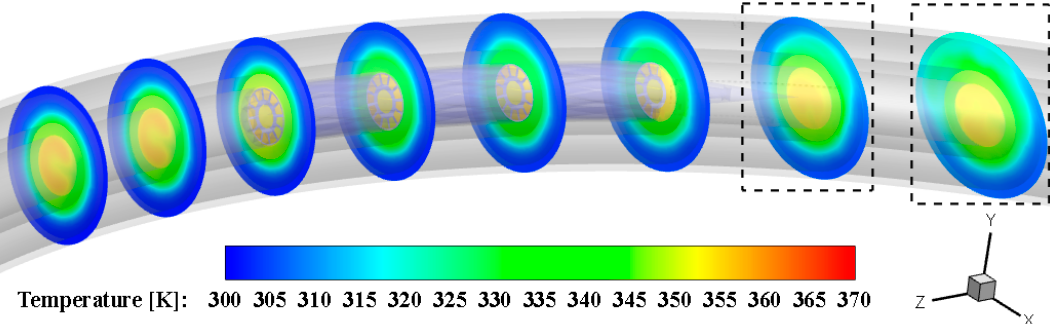
Figure 9. The produced secondary (swirl) flows with contours of temperature and velocity magnitude from the exit of swirl generator’s holes, and the fluid flow over the blades.